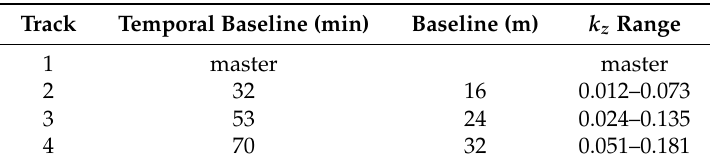
Figure 5. Test site Krycklan Catchment: P-band RGB composite intensity image in the Pauli-basis, including 26 forest stands marked by red polygons. Table 1. Parameters of airborne interferometric pairs.